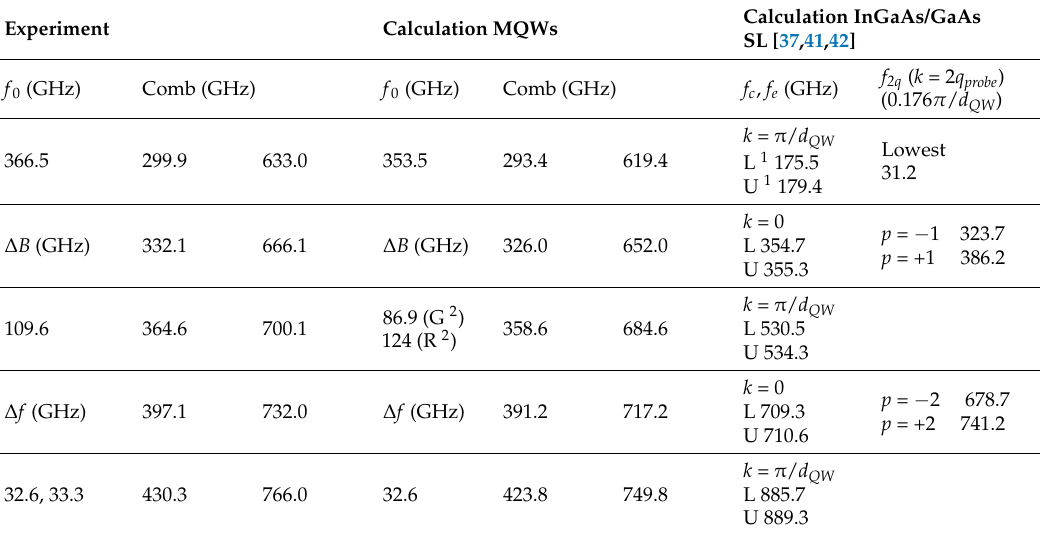
Table 3. Acoustic phonon spectrum in the high frequency